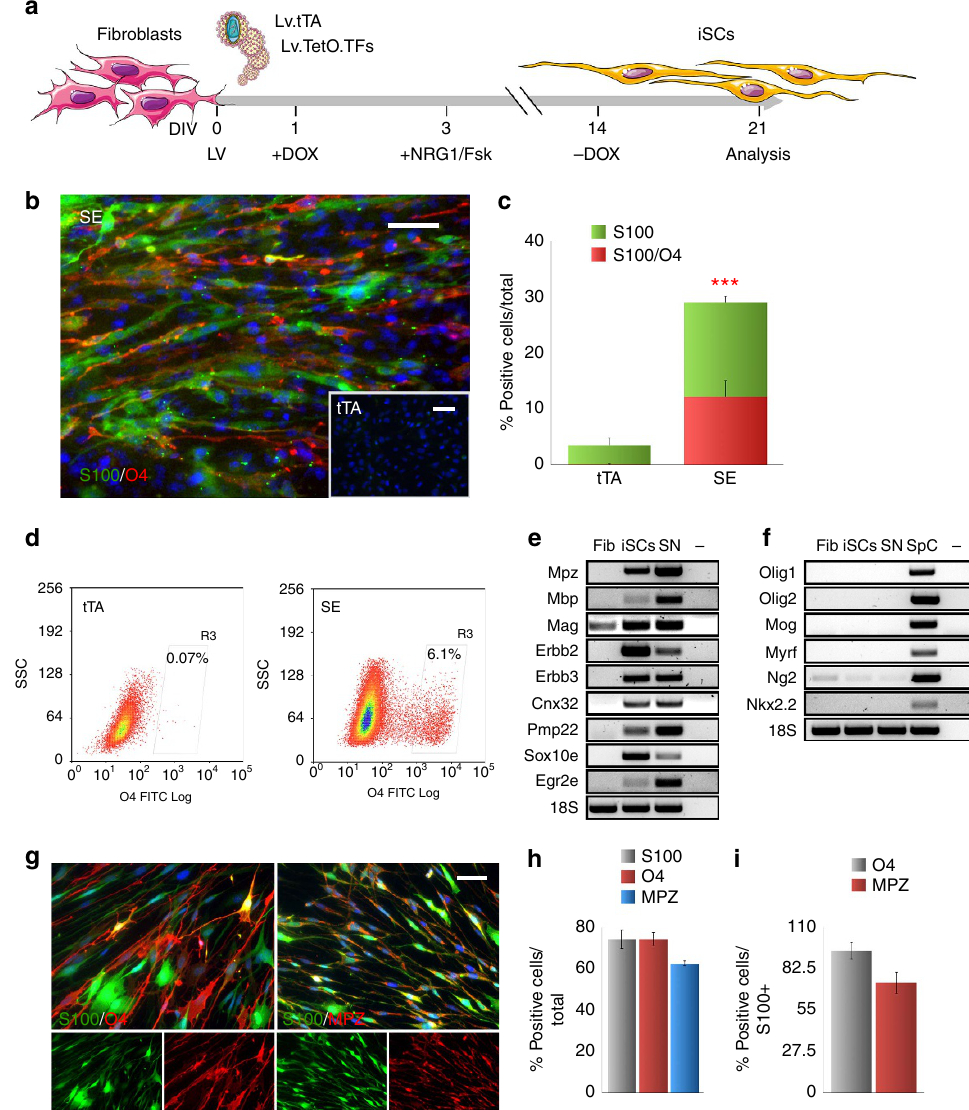
Figure 1 | Direct conversion of mouse skin fibroblasts into iSCs. ( a ) Schematic representation of the reprogramming strategy for generating iSCs using the dox-inducible lentiviral transgenes expressing tTA, combinations of transcription factors (TFs) together with the small molecules NRG1 and Fsk. ( b ) S100 (green) and O4 (red) immunofluorescence staining of Sox10/Egr2 (SE) or tTA-infected (inset) MEFs. ( c ) Quantification of S100 þ and S100 þ /O4 þ cells expressed as percentage over the total number of cells in experimental (SE) and control (tTA) conditions at 14 DIV (Mean ± s.d., n ¼ 8 independent experiments, 10 randomly selected 20 (cid:2) fields per sample were examined). ( d ) Fluorescence-activated cell sorting-based purification of the O4 þ iSC population. ( e ) Expression of SC cardinal markers by RT–PCR in fibroblasts (Fib), induced SCs and adult sciatic nerve (SN, positive control). Sox10e, endogenous Sox10, Egr2e, endogenous Egr2. ( f ) Expression of Oligodendrocyte-specific markers by RT–PCR in fibroblasts (Fib), induced SCs, sciatic nerve (SN) and P20 spinal cord (SpC, positive control). ( g ) S100/O4 and S100/MPZ immunofluorescence staining in iSCs. ( h , i ) Quantification of 14 DIV iSCs expressing S100, O4 and MPZ alone or in combination (Mean ± s.d., n ¼ 6 independent experiments, three coverslips/experiment/antigen, 10 randomly selected 20 (cid:2) fields per sample were examined). *** P o 0,001; Student’s t -test. Scale bars, 50 m